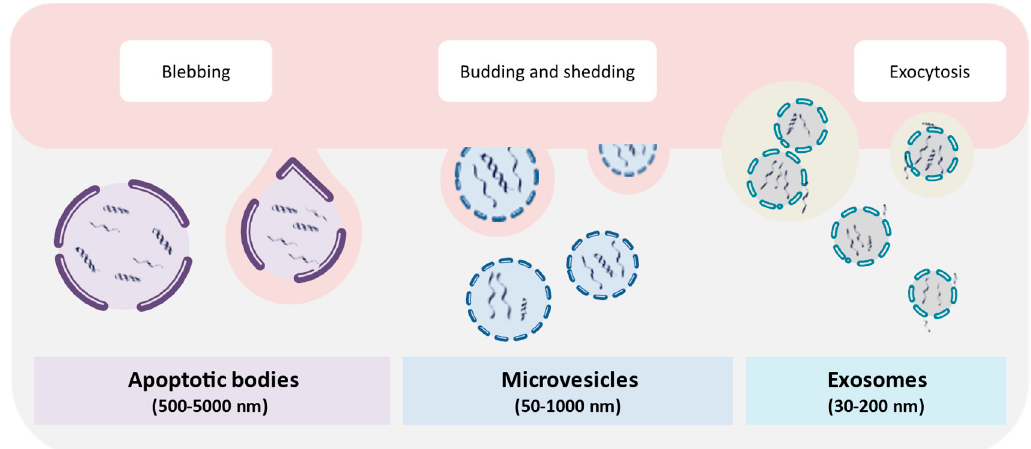
Figure 2. Different extracellular vesicle (EV) types in the human body. The three main types of EVs that occur in human body fluids include microvesicles, apoptotic bodies, and exosomes. These vesicles can be differentiated based on the mode of their production, cellular extrusion pathways, and their overall size. In addition, EVs can be stratified according to their content and function.